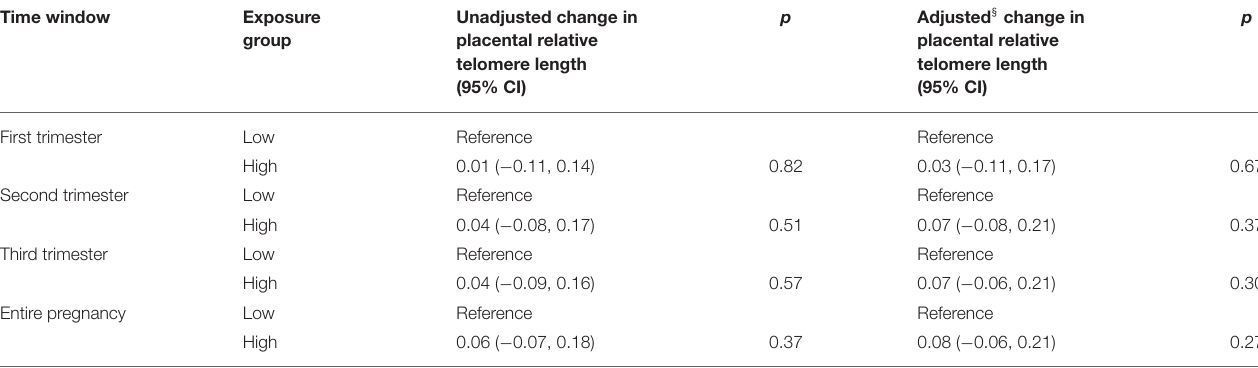
TABLE 6 | Linear regression analysis of placental telomere length in women with high NO x exposure as compared with women with low NO x exposure (median cut-off). Time